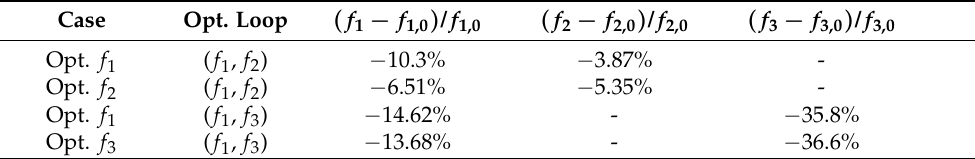
Table 2. Improvement percentages for the bi-objective optimal